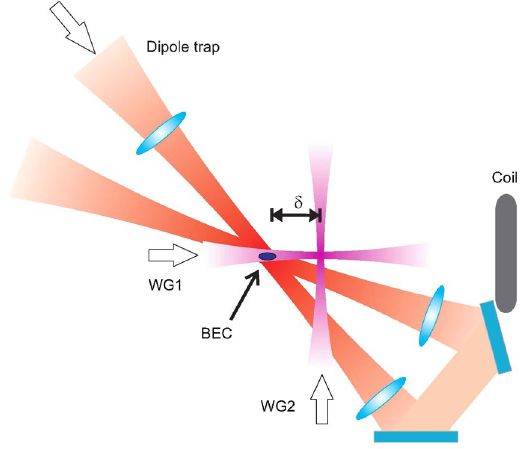
Figure 7. Schematics of the experimental apparatus.